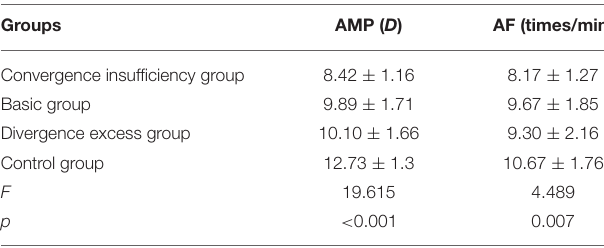
TABLE 4 | Comparison of binocular AMP and AF among four groups (x ± s ).